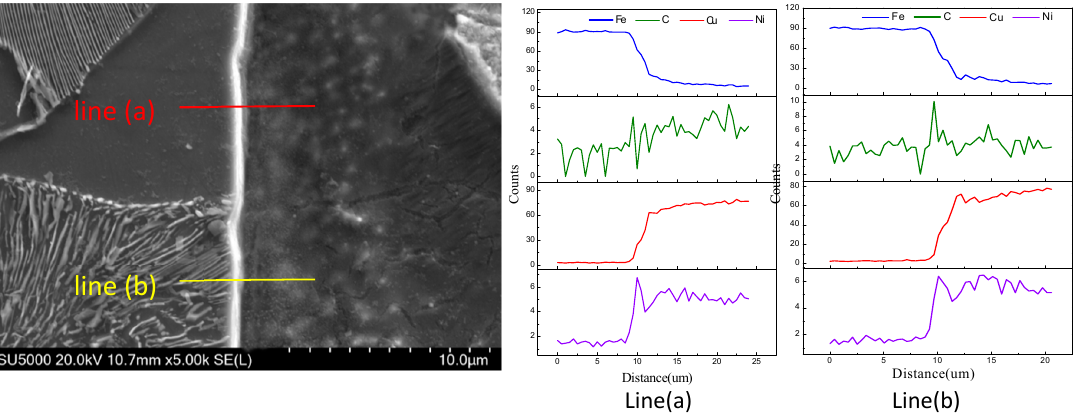
/ copper bimetallic